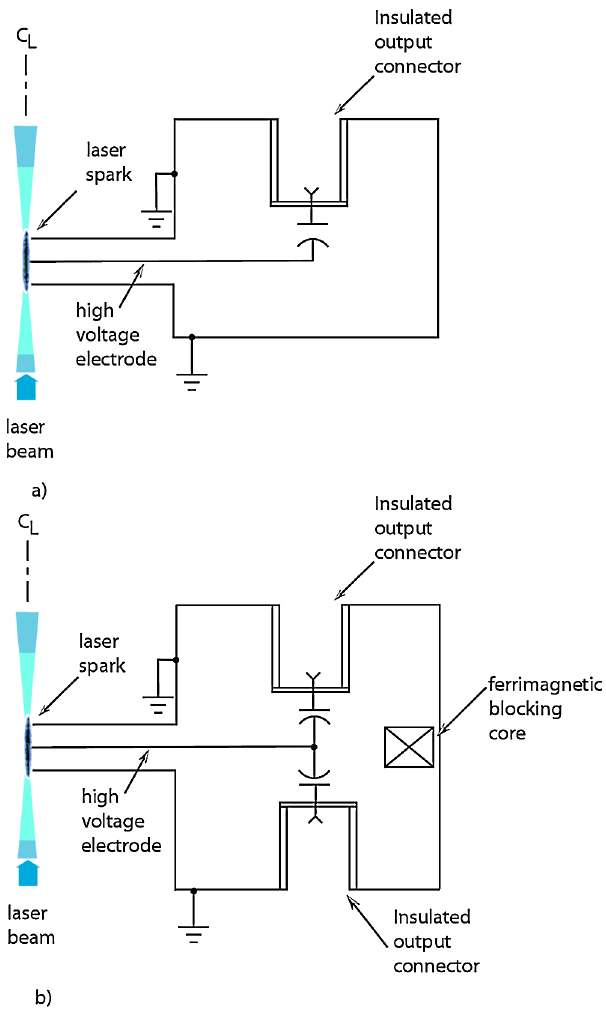
FIG. 1. (Color) Conceptual diagram of the two-channel laser- triggered pulse generator. The switch center plate is charged to high voltage. Current flows in two parallel laser-created spark channels to the grounded electrodes. The pulser system is axisymmetric (with the laser beam on axis) for lowest induc- tance. Upper figure: single-sided output. Lower figure: fully symmetric two sided output with blocking ferrite (see